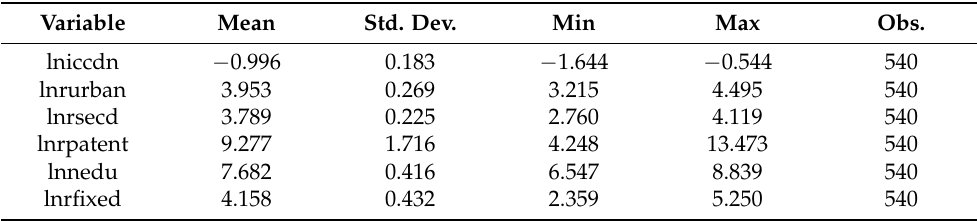
Table 3. Urban resilience evaluation index